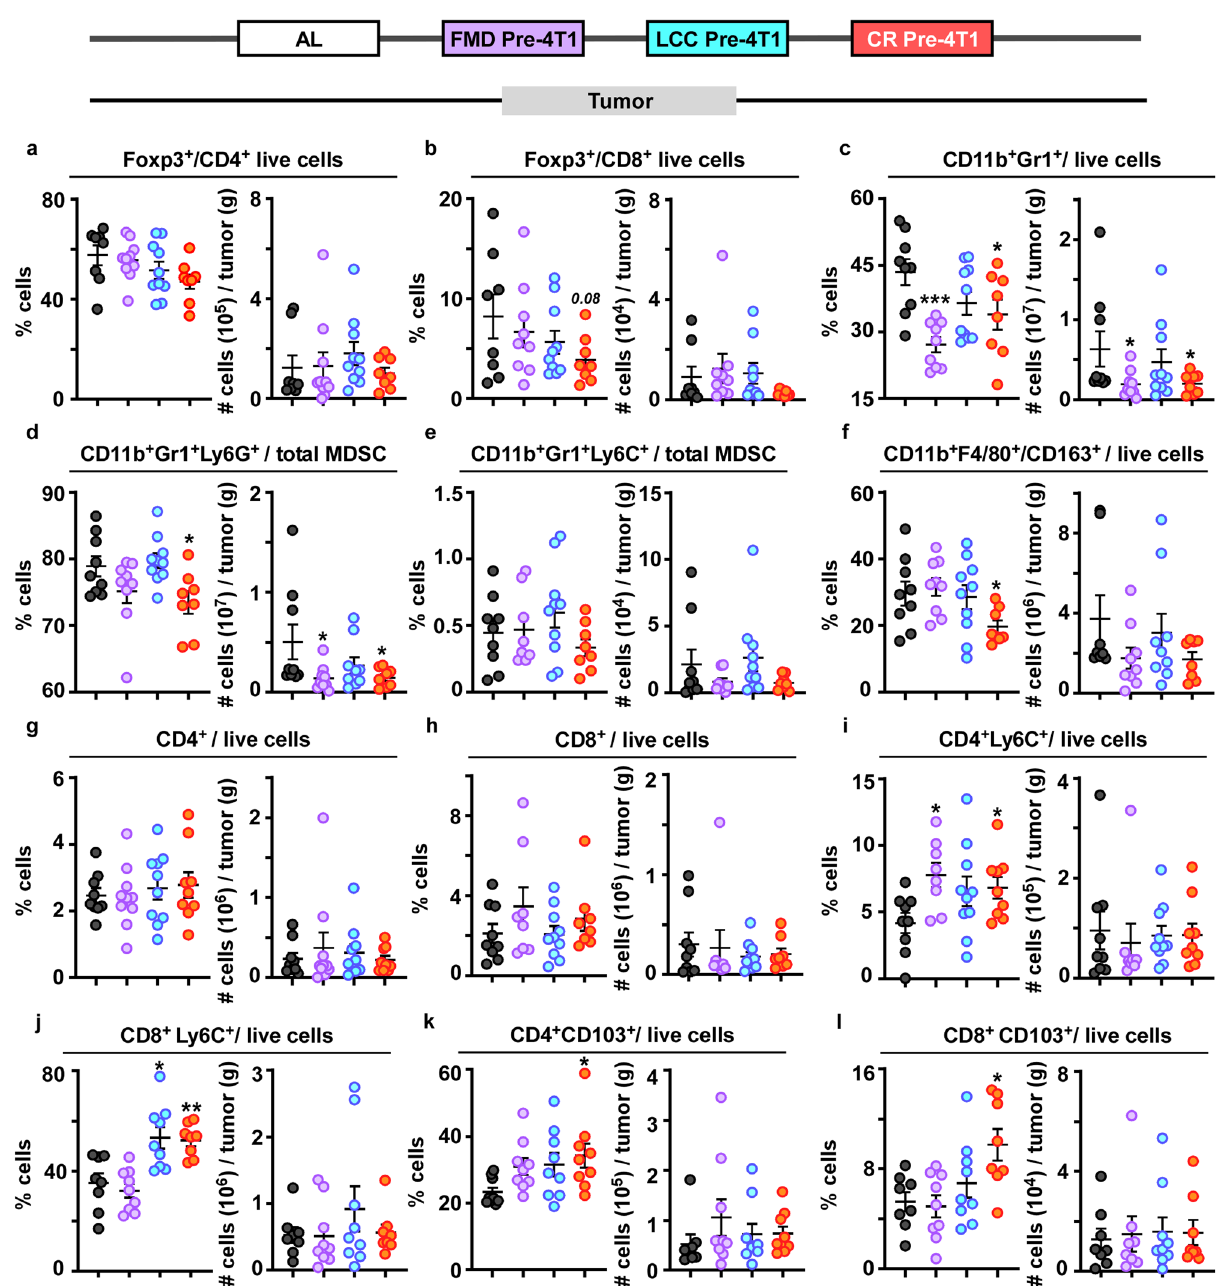
Fig. 7 Immunological remodeling in the tumor microenvironment. Frequency (%) (left) and cell count per gram of tumor (#) (right) of immune cells identi fi ed in the primary tumor collected from mice undergoing dietary regimens initiated prior to 4T1 implantation (Fig. 4). a Foxp3 + CD4 + T regulatory cells; b Foxp3 + CD8 + T regulatory cells; and c CD11b + Gr1 + cells (MDSCs). MDSC subset detected in the primary tumor, d CD11b + Gr1 + Lys6G + (granulocytic-MDSCs), and e CD11b + Gr1 + Lys6C + (monocytic-MDSCs). f CD11b + F480 + CD163 + immunosuppressive cells. g Effector CD4 + and h effector CD8 + cells. i CD4 + Lys6C + cells and j CD8 + Lys6C + cells. k CD4 + CD103 + cells and l CD8 + CD103 + cells. Scatter plots represent mean values ± SEM. One-way ANOVA with Tukey post hoc analysis was used to determine statistical signi fi cance with * p < 0.05, ** p < 0.01, *** p < 0.001. a AL, n = 8; FMD pre-4T1, n = 10; LCC pre-4T1, n = 10; CR pre-4T1, n = 8. b AL, n = 8; FMD pre-4T1, n = 9; LCC pre-4T1, n = 10; CR pre-4T1, n = 8. c , d, f AL, n = 9;